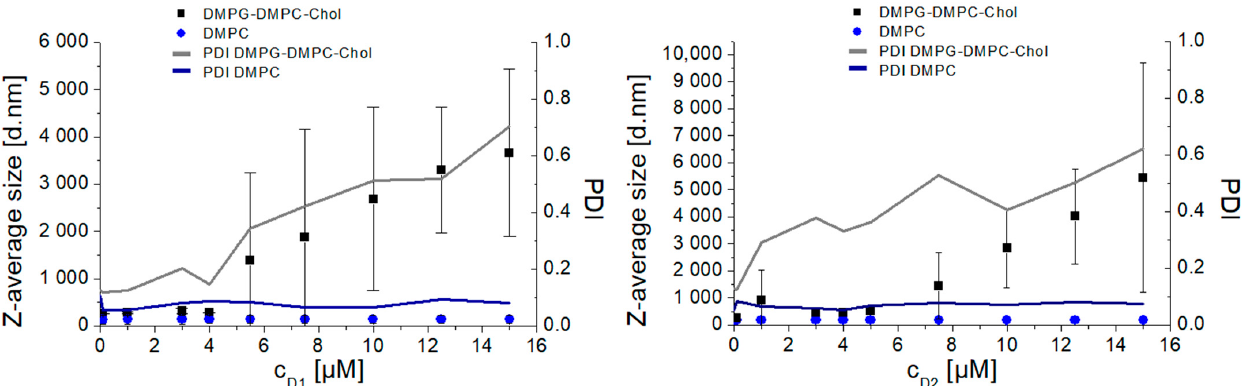
Figure 4. The hydrodynamic diameter (Z-average; (d.nm + SD)) and polydispersity index (PDI) of zwitterionic DMPC and negatively charged DMPG − DMPC − Chol liposomes upon the increasing concentration of D1 ( left ) and D2 ( right ) dendrons in Na-phosphate buffer (10 mM, pH 7.4) at 25 °C. Error bars represent standard deviations.